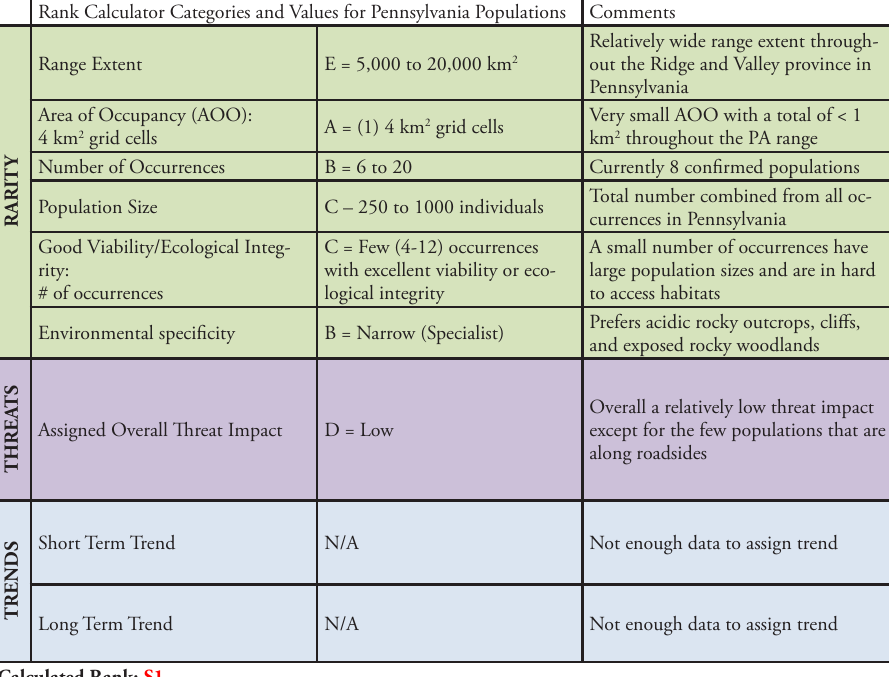
Table 2. NatureServe Rank Calculator assessment output with comments concerning population num- ber, size, and area of occupancy of Heuchera alba in